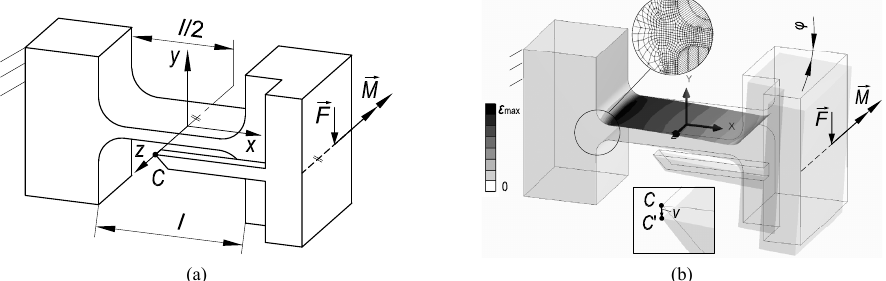
Figure 11. FEM-based characterization of a flexure hinge: (a) CAD model, (b) FEM model with deformed hinge and mesh details.